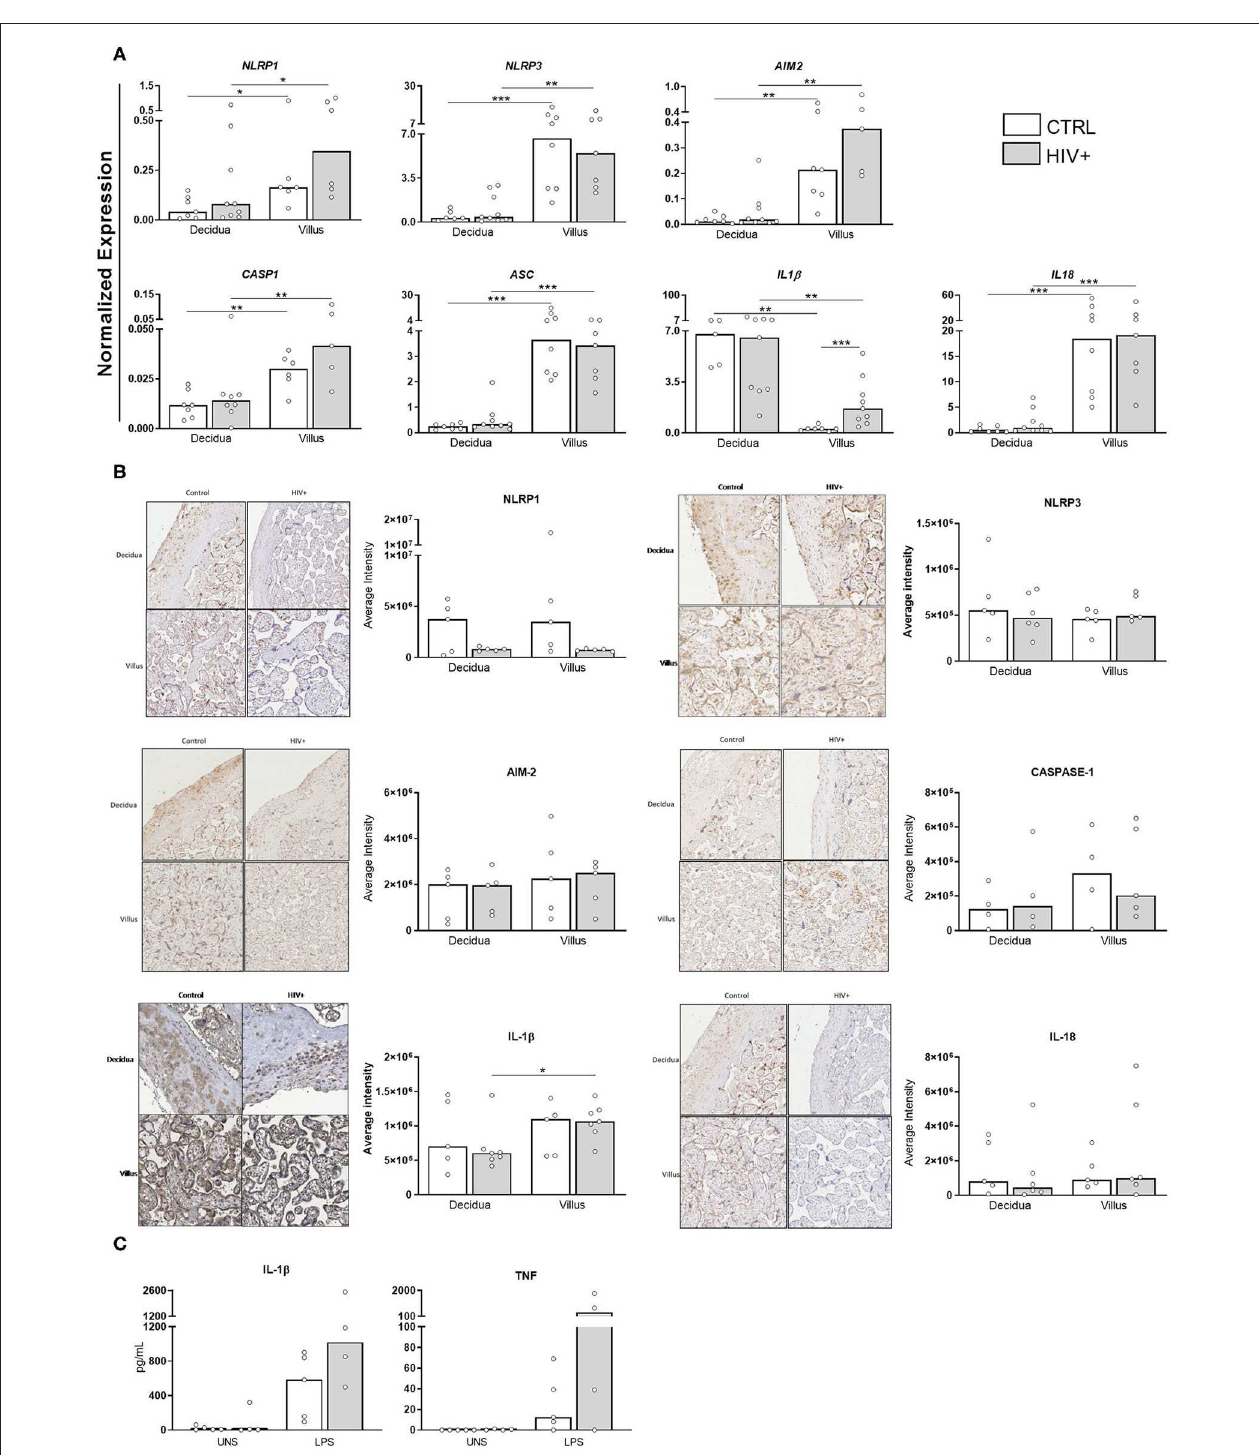
FIGURE 2 | Differential expression of IL1B transcripts in placental chorionic villi. (A) mRNA expression levels of NLRP1, NLRP3, AIM-2, Caspase1, ASC, Pro-IL-1 β , and Pro-IL-18 in decidua and placental chorionic villi from HIV-infected mothers (gray bar, n = 5–9) and control uninfected mothers (white bar, n = 5–8) was evaluated by RT qPCR. (B) NLRP1, NLRP3, AIM-2, caspase-1, IL-18, and IL-1 β protein levels were analyzed by immunohistochemistry in decidua and placental chorionic villi from HIV-infected mothers (gray bar, n = 4–6) and uninfected mothers (white bar, n = 4–5). (C) Secretion levels of IL-1 β and TNF in supernatants from placental explants from HIV-infected (gray bar, n = 4) and control uninfected mothers (white bar, n = 5) stimulated with TL4 agonist was evaluated by cytometric bead array. UNS = unstimulated. The detection limits were: IL-1 β = 2.3 fg/mL; TNF = 0.7 pg/mL. Expression values are represented as median. Mann-Whitney U or Wilcoxon signed-rank test: * p < 0.05, ** p < 0.01, *** p < 0.001.